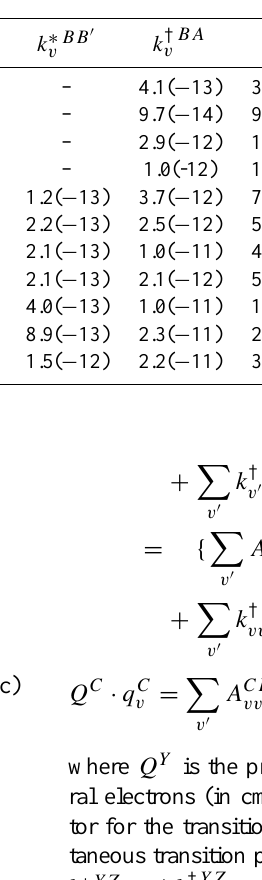
Table 2. Applied rate coefficients in Eq.